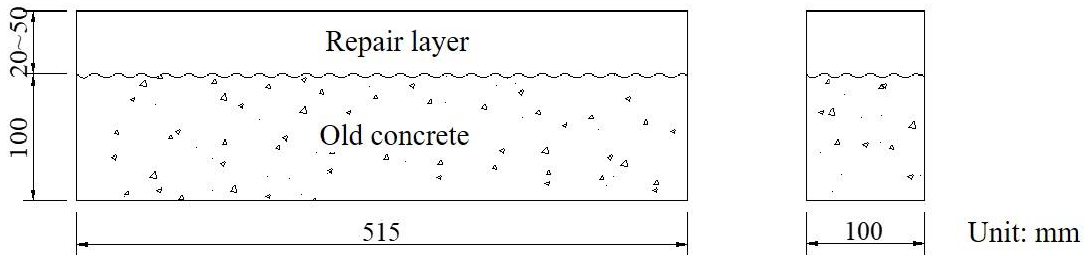
Figure 3. Schematic diagram of SHCC-repaired concrete beam.